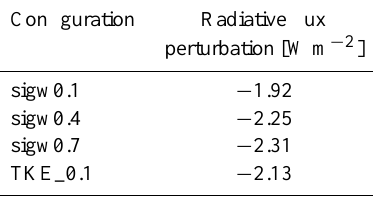
Table 8. Difference in global mean SW cloud radiative effect be- tween pairs of present-day simulations from different model con-